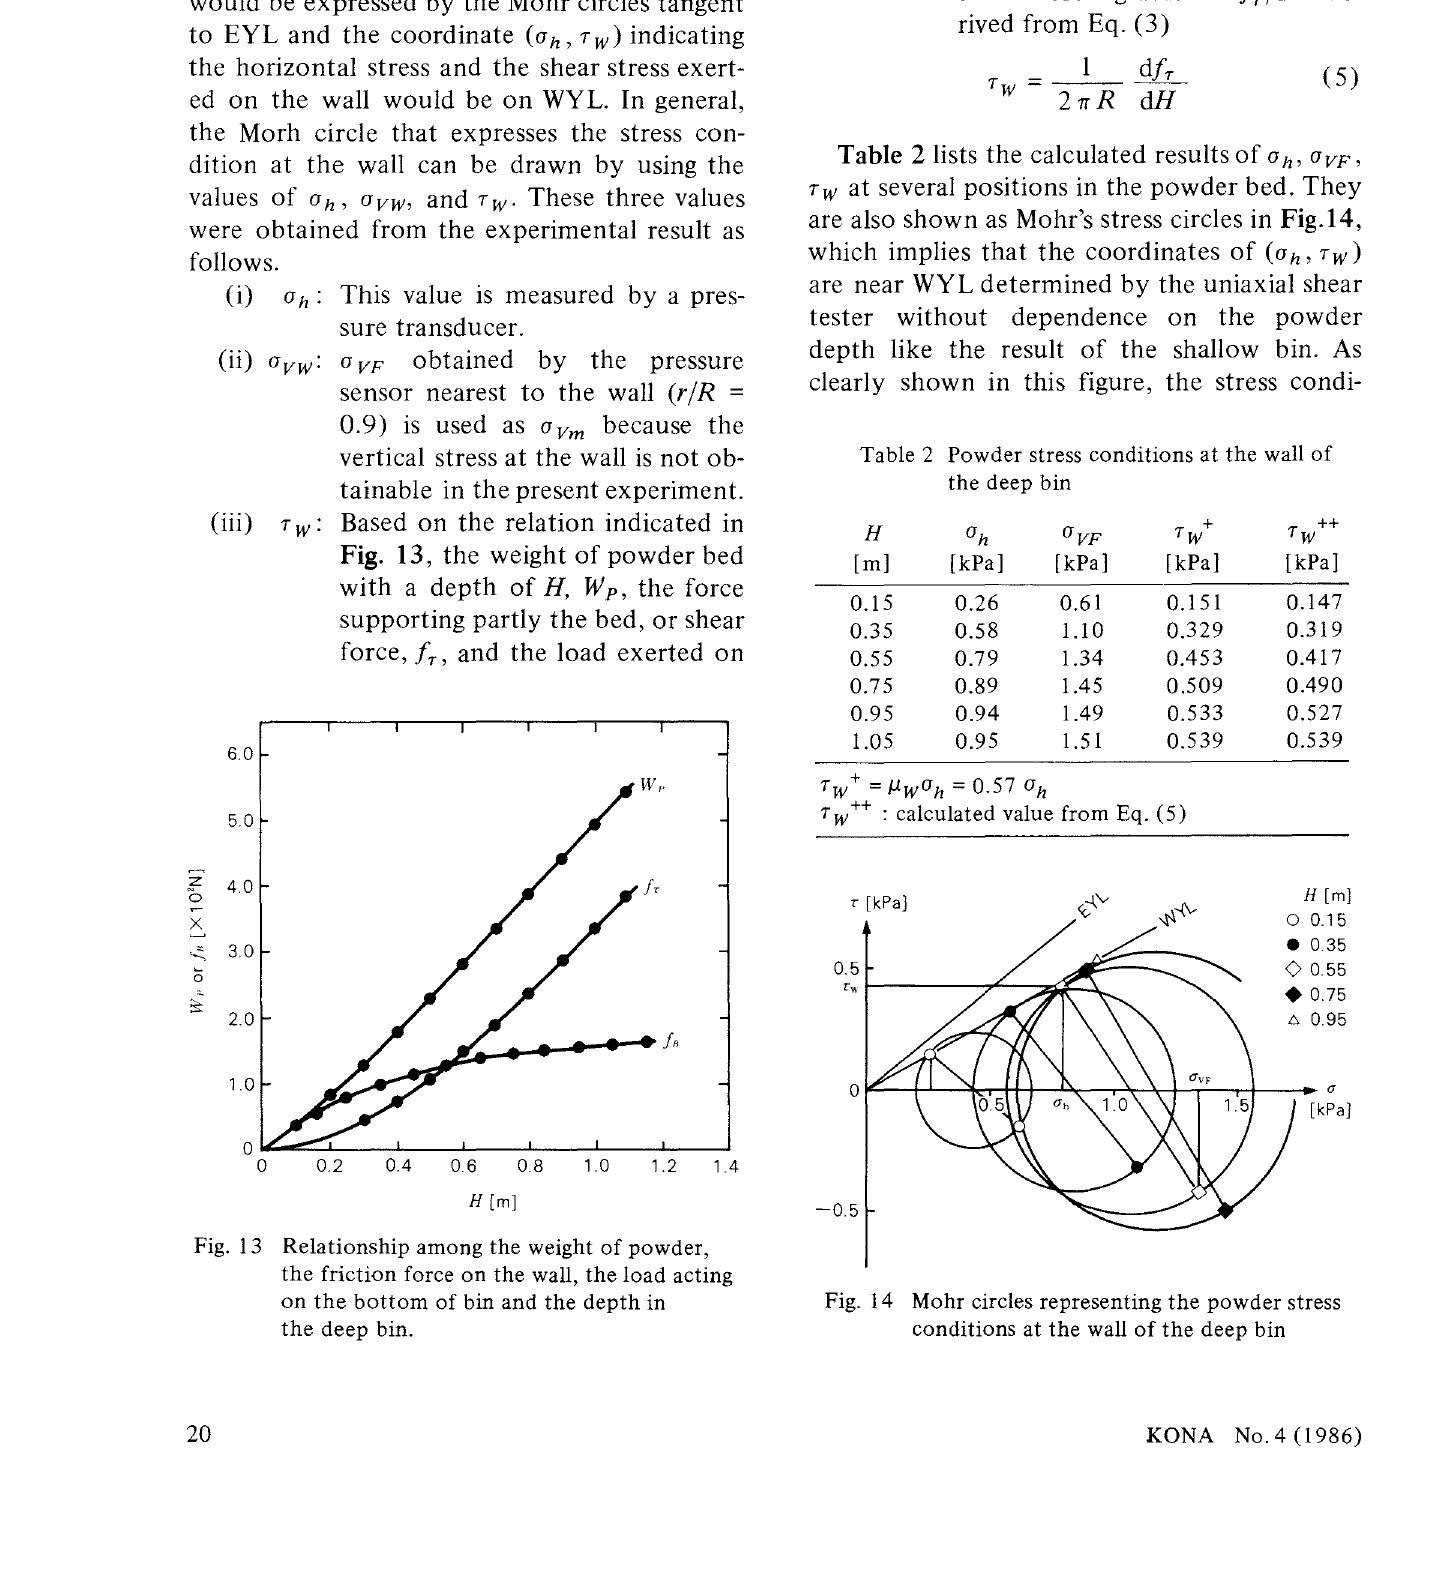
Fig. 14 Mohr circles representing the powder stress conditions at the wall of the deep